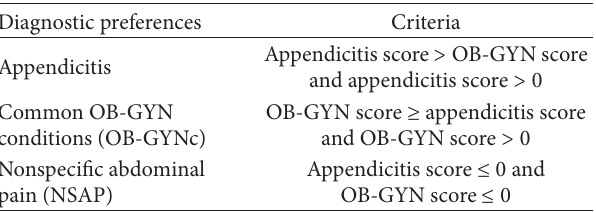
Table 3: Criteria for diagnostic preferences in acute lower abdomi- nal pain, using the derived